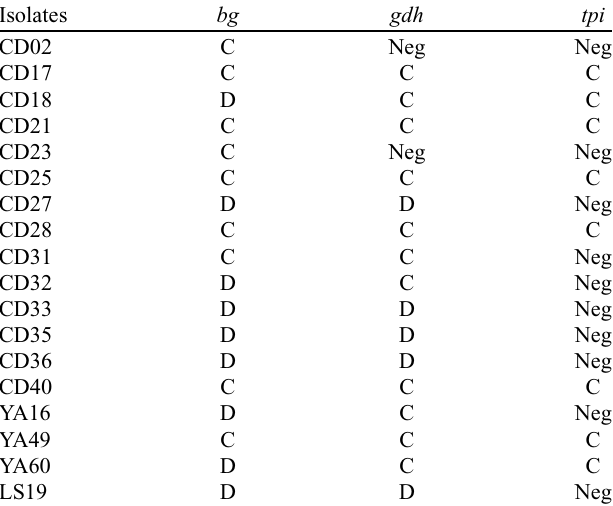
Note : CD represents Chengdu, YA represents Yaan, and LS represents Leshan; Neg represents